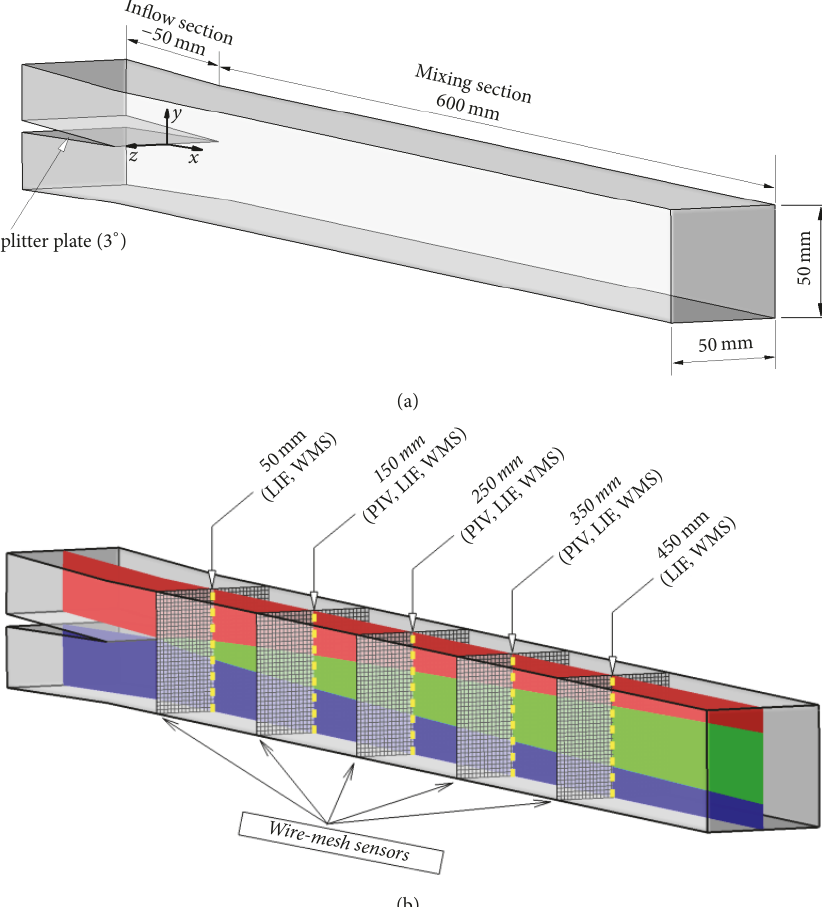
Figure 1: The geometry of the GEMIX computational domain (a) and the measuring positions (b). The turbulent mixing zone is illustrated by green colour [3].